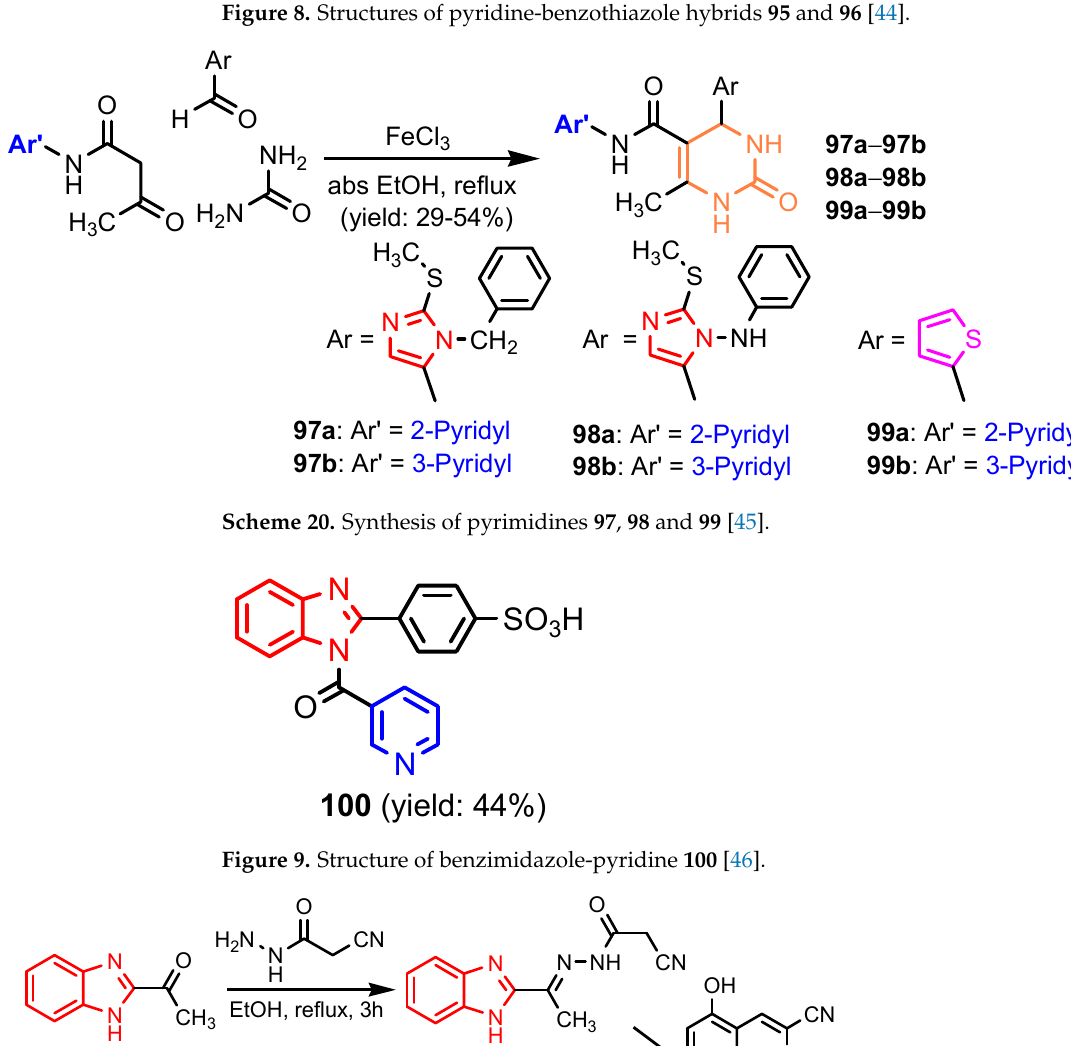
Figure 8. Structures of pyridine-benzothiazole hybrids 95 and 96 [44].